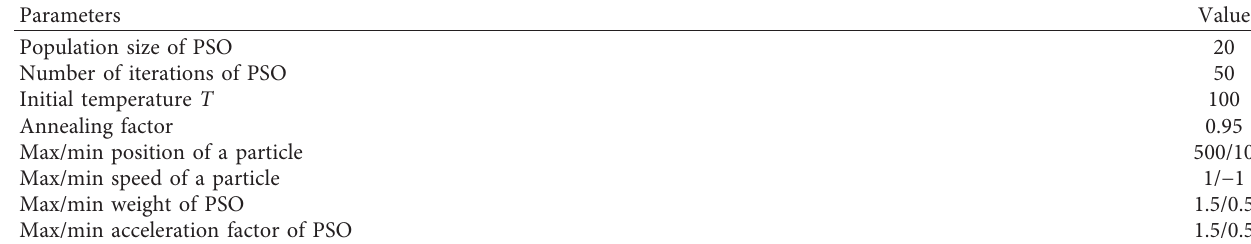
Table 2: Parameter settings for the hybrid PSO-SA.